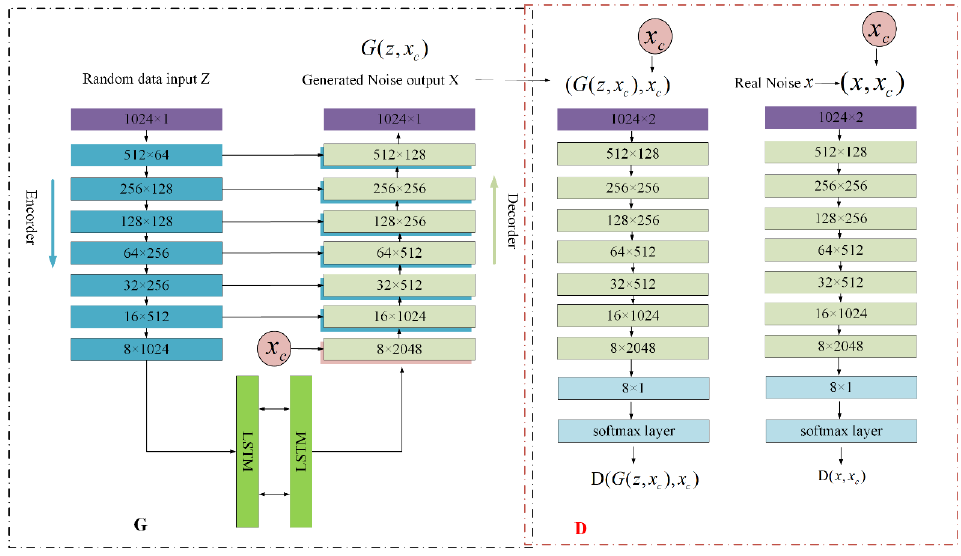
Figure 3. NM-GAN structure.